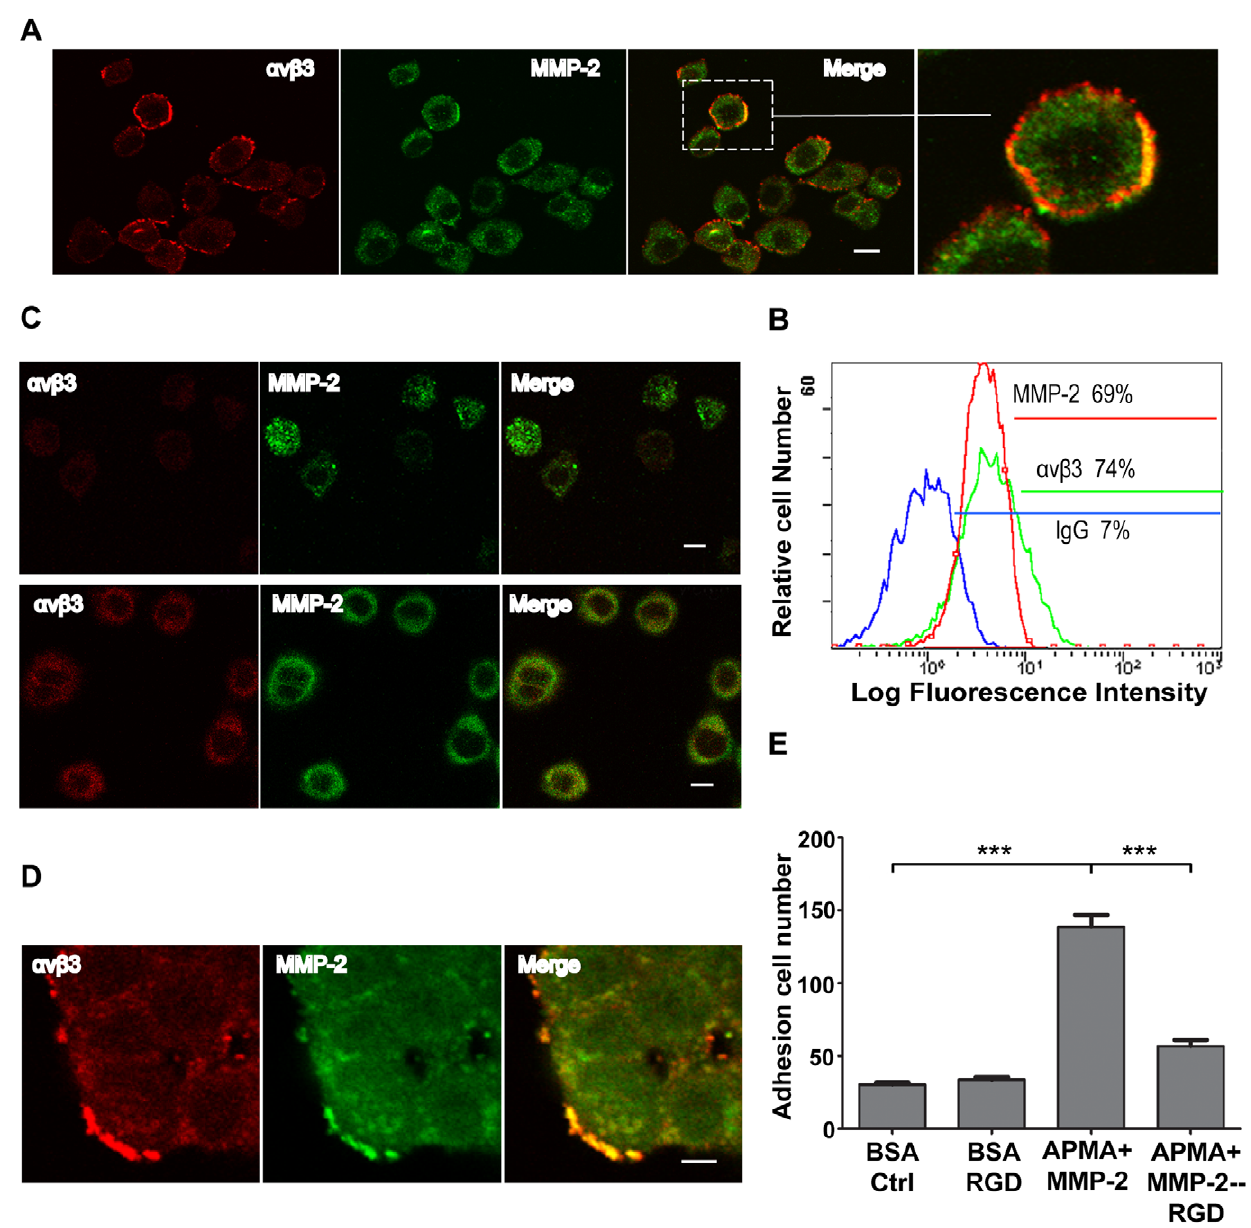
Figure 1. Expression of MMP-2 and a v b 3 in human A375 melanoma cells. (A) Cells were suspended in PBS and labeled with anti- a v b 3 (red) and anti-MMP-2 (green) antibodies. Scale bar=10 m m. (B) Flow cytometric analysis of a v b 3 integrin and MMP-2 expression on the cell surface. The expression of a v b 3 integrin and MMP-2 was evaluated using anti- a v b 3 and anti-MMP-2 antibodies, and isotype IgG was used as a negative control. (C) A375 cells were seeded onto coverslips coated with human fibronectin for 30 min (upper panel) and 3 h (lower panel), then labeled with anti- a v b 3 (red) and anti-MMP-2 (green) antibodies. Scale bar=10 m m. (D) A375 cells in agarose drops were seeded onto coverslips coated with human fibronectin. The cells were labeled with anti- a v b 3 (green) and anti-MMP-2 (red) antibodies 24 h after seeding and observed under a confocal microscope. Scale bar=10 m m. (E) A375 cells were fluorescently stained and seeded on 96 well flat-bottom plates coated with APMA-activated recombinant human MMP-2 or 0.5% BSA. The control cells were treated using RGD peptides.